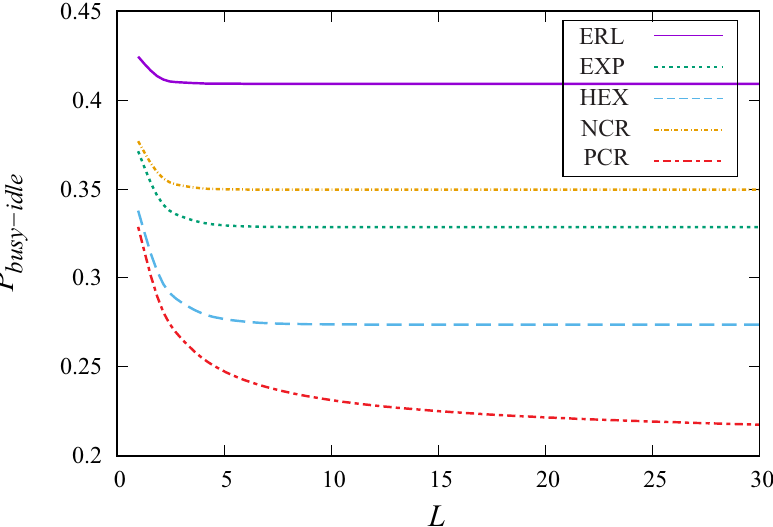
Figure 6. Dependence of the probability P busy − idle that the main server is busy while the secondary server is idle on the parameter L for different MAP